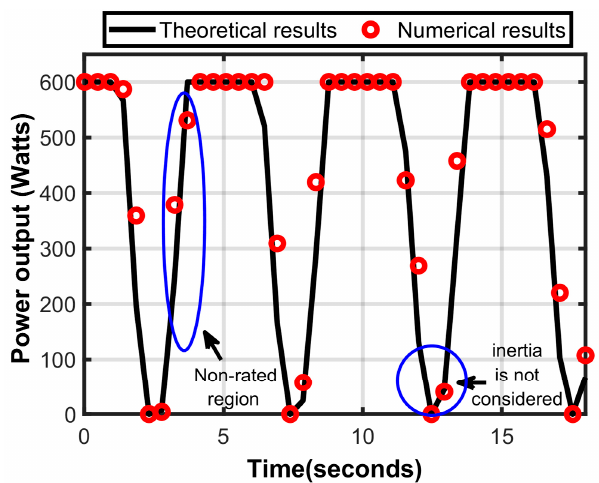
Figure 7. Power output